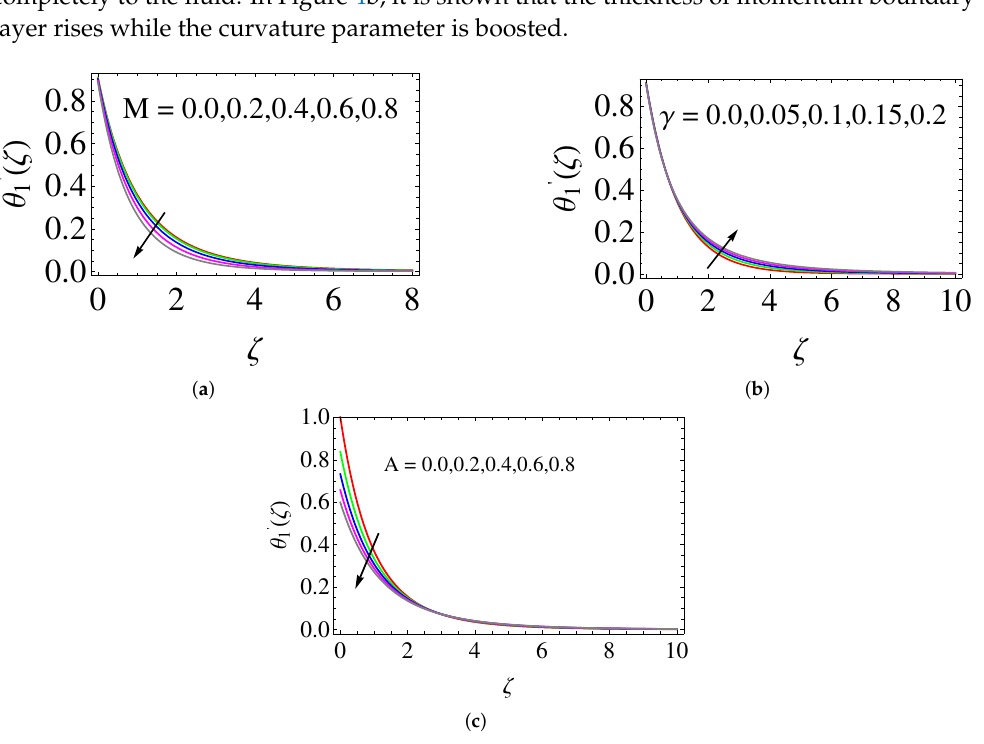
From Table 4, it is clear that the skin friction coefficient θ (cid:48)(cid:48) γ ( > 0) and M but it decreases while elevating A ( > 0). Table 4. Numerical values of skin friction coefficient θ (cid:48)(cid:48) γ A Hayat et al. [17] Present